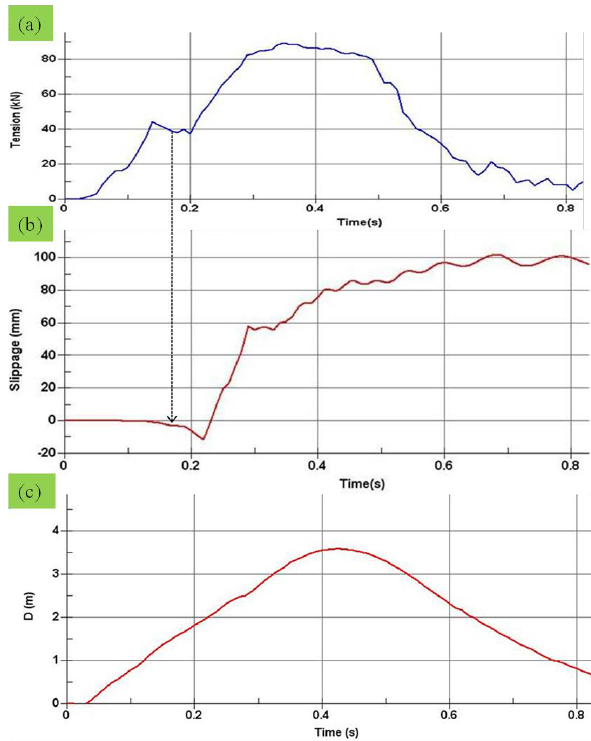
Figure 8. Numerical simulation (NM) results. (a): Maximum cable-tension, at location M. (b) 2 Fig. 8. Numerical simulation (NM) results. (a) : maximum Maximum UFD-slippage (slip-displacement), at location M. (c) Maximum wire-net‟s out-of-3 cable-tension, at location M. (b) Maximum UFD-slippage (slip- displacement), at location M. (c) Maximum wire-net’s out-of-plane plane displacement, just below the impact point. See also Fig. 3 for the corresponding FM 4 displacement, just below the impact point. See also Fig. 3 for the results. 5 corresponding FM results.